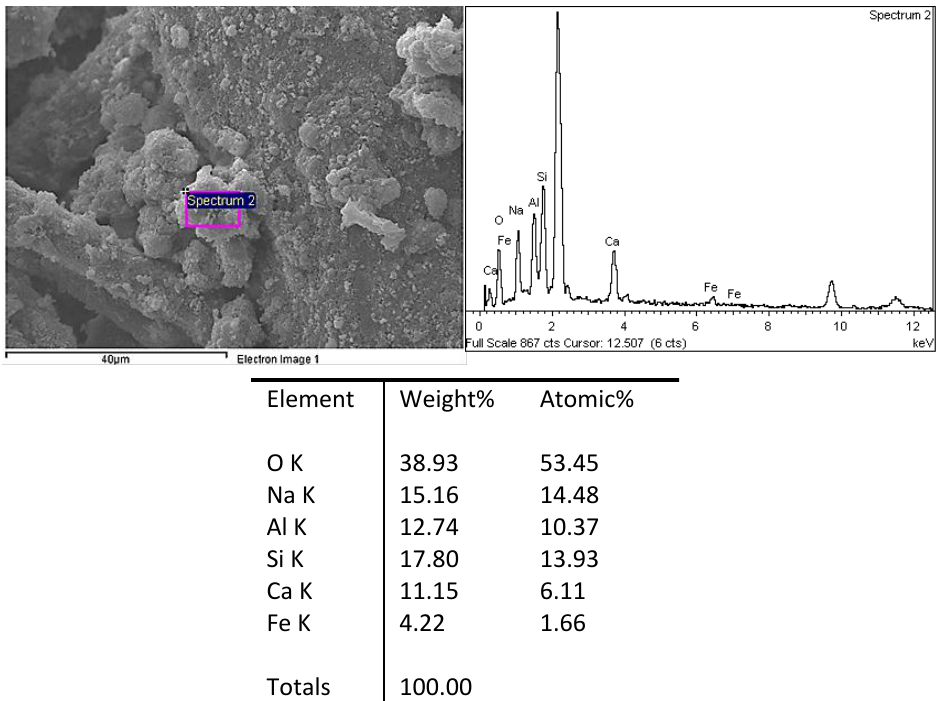
Figure 16. EDS spectrum alkali-activated cement (Act.3—0%).